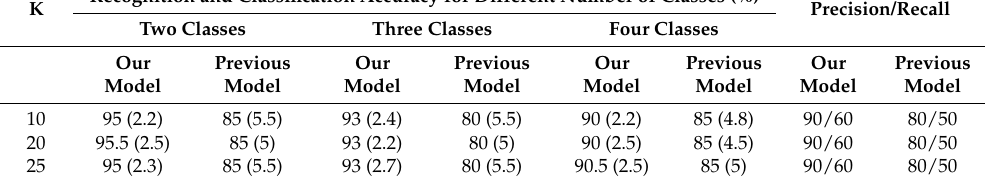
Table 3. A comparison of recognition and classification accuracy for different yarn colors between our model and the HMAX model with and SVM-based classifier (shirt fabric; color type), with standard deviation in